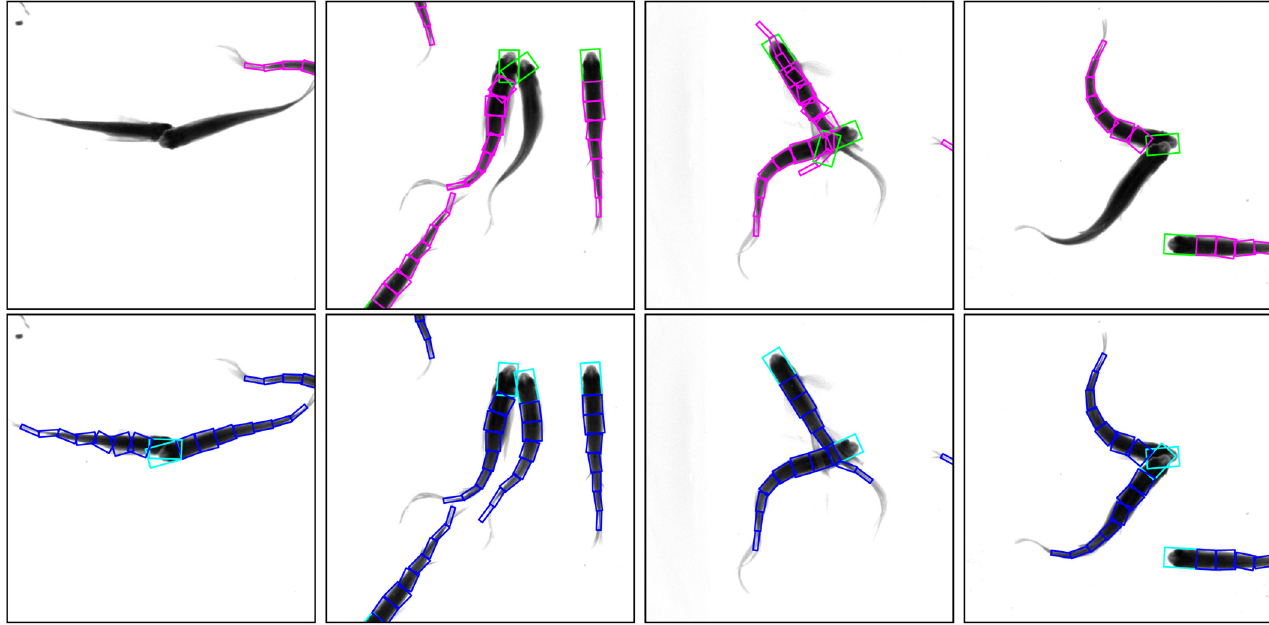
Fig 8. Examples of successful correction of detection failure. Images in the first row present four examples of detection failures including detection error, detection missing and duplication detection. The failures are successfully corrected in tracking stage, see images in the second